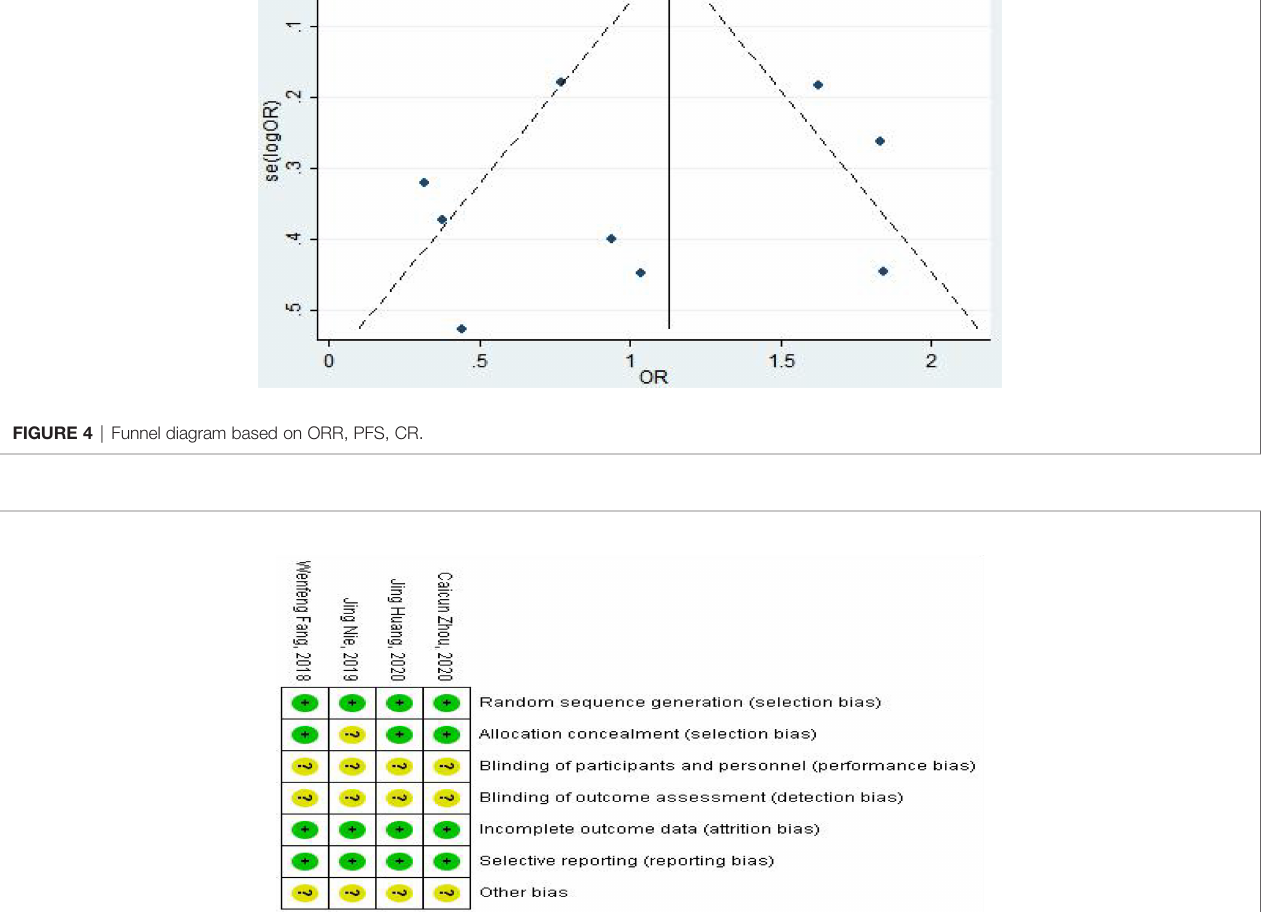
FIGURE 5 | Summary chart of bias